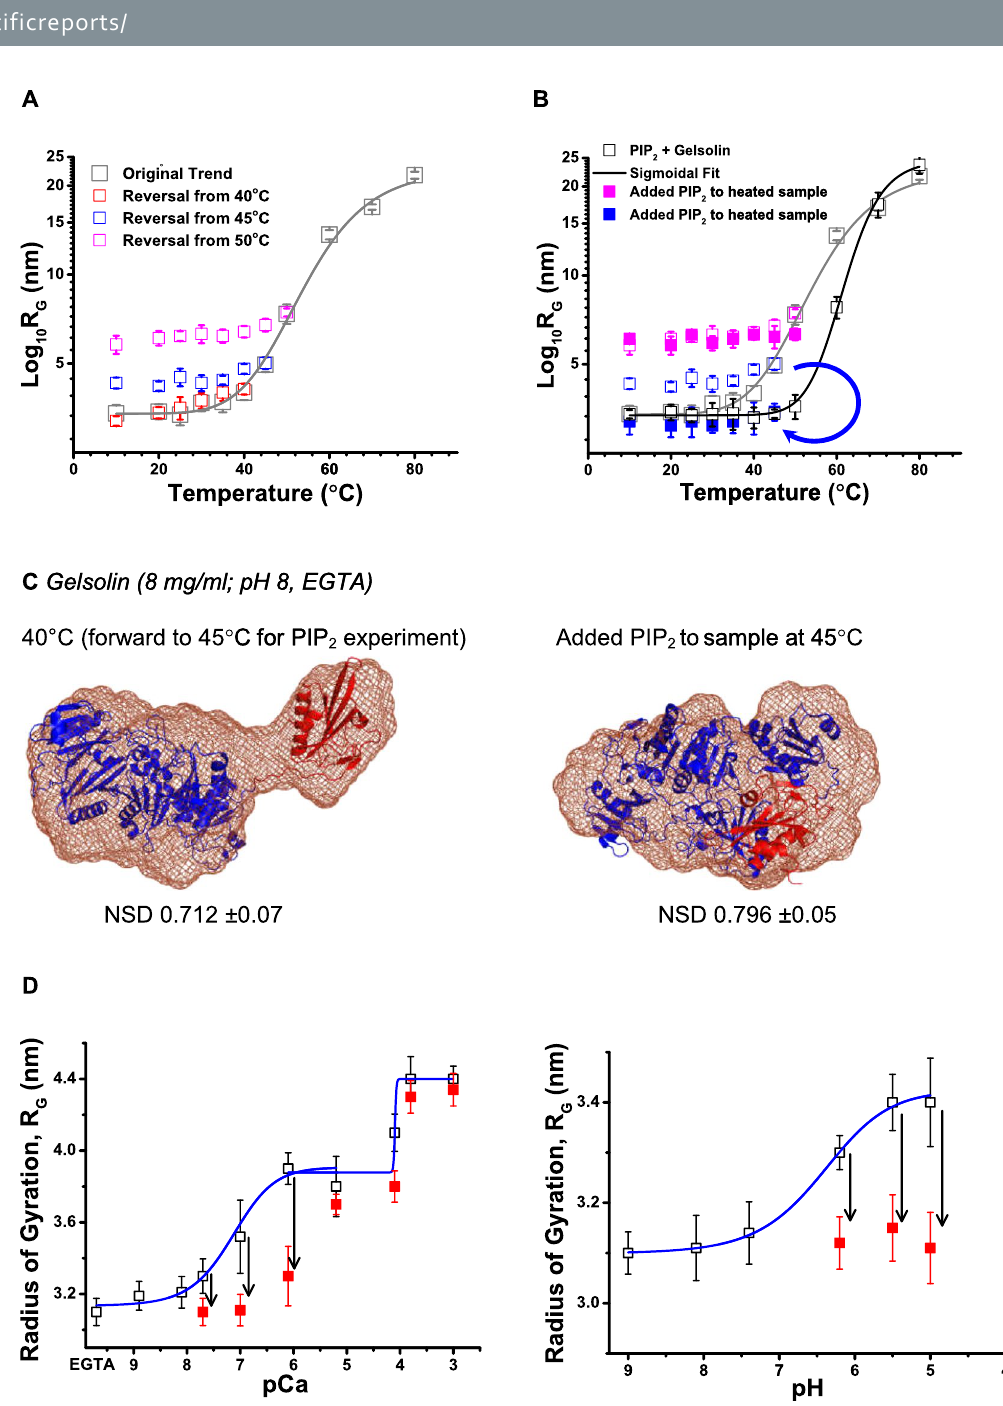
Figure 6. ( A ) Variation in R G values of gelsolin molecules in absence of PIP 2 as tracked by Guinier analyses of the SAXS datasets obtained at different temperatures are shown. The data here shows whether the R G values decrease upon lowering the sample temperature or not. ( B ) Computed R G values from SAXS datasets obtained from samples of gelsolin mixed with PIP 2 are presented here as function of temperature. The blue arrow highlights the PIP 2 addition induced decrement in R G values in gelsolin samples pre-heated to 45 °C. ( C ) SAXS data based scattering shape solved for gelsolin molecules at 40 and 45 °C but without and with PIP 2 in solution, respectively are shown here (dummy residues shown as brown mesh). As detailed in discussion section, models were placed inside SAXS data based shape profiles for comparison. ( D ) The panels show the variation in R G values of gelsolin value as a function of free Ca 2 + ions (left) or low pH in buffer (black open squares). The filled red squares show the R G values of the samples having same amount of Ca 2 + ion or pH in buffer, plus PIP 2 . The black arrows highlight decrement in the R G values upon addition of PIP 2